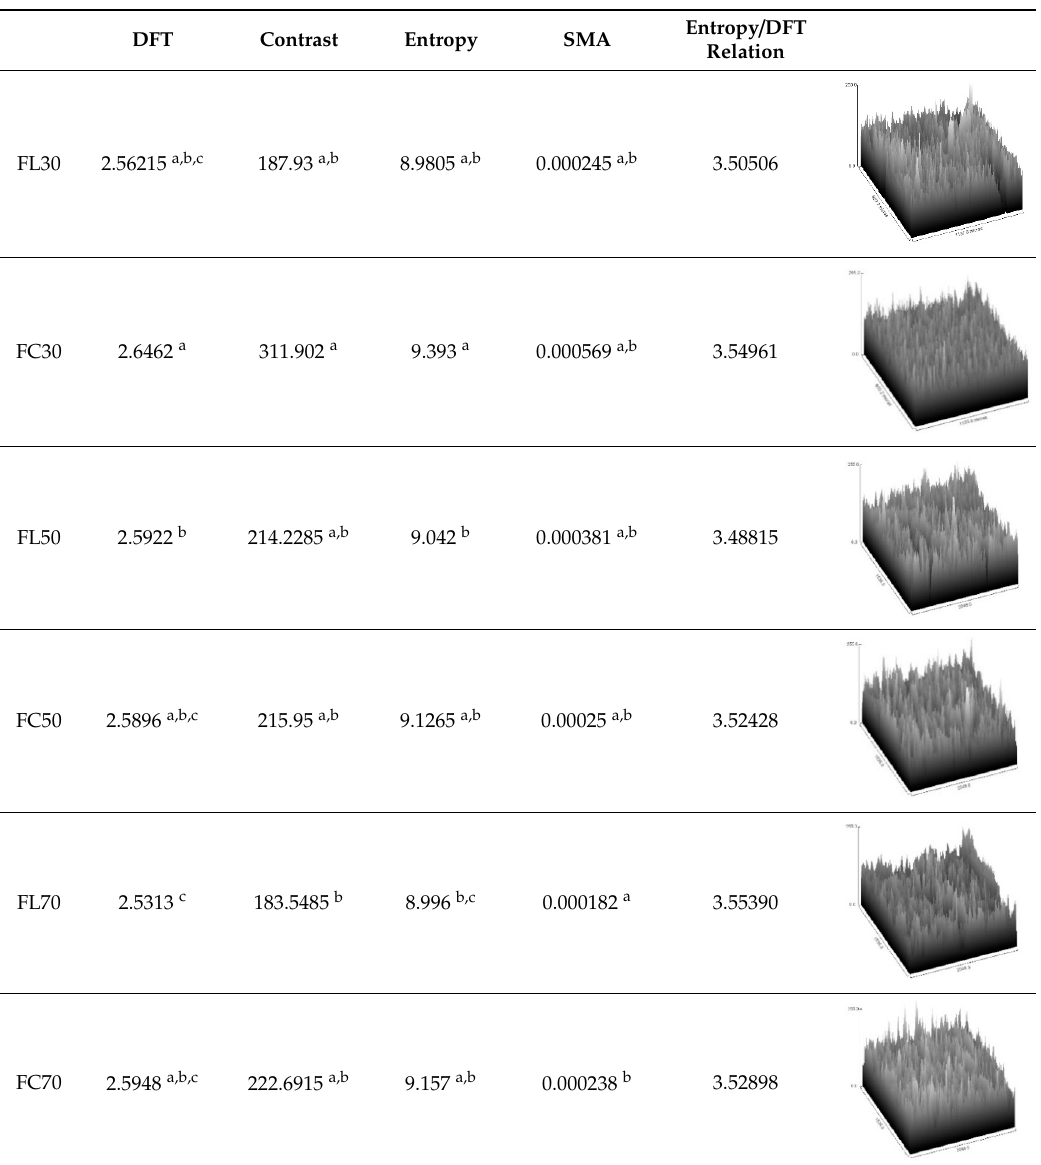
Table 7. Analysis of texture images of the ESEM micrographs of the LMBs (SMA: second angular momentum).